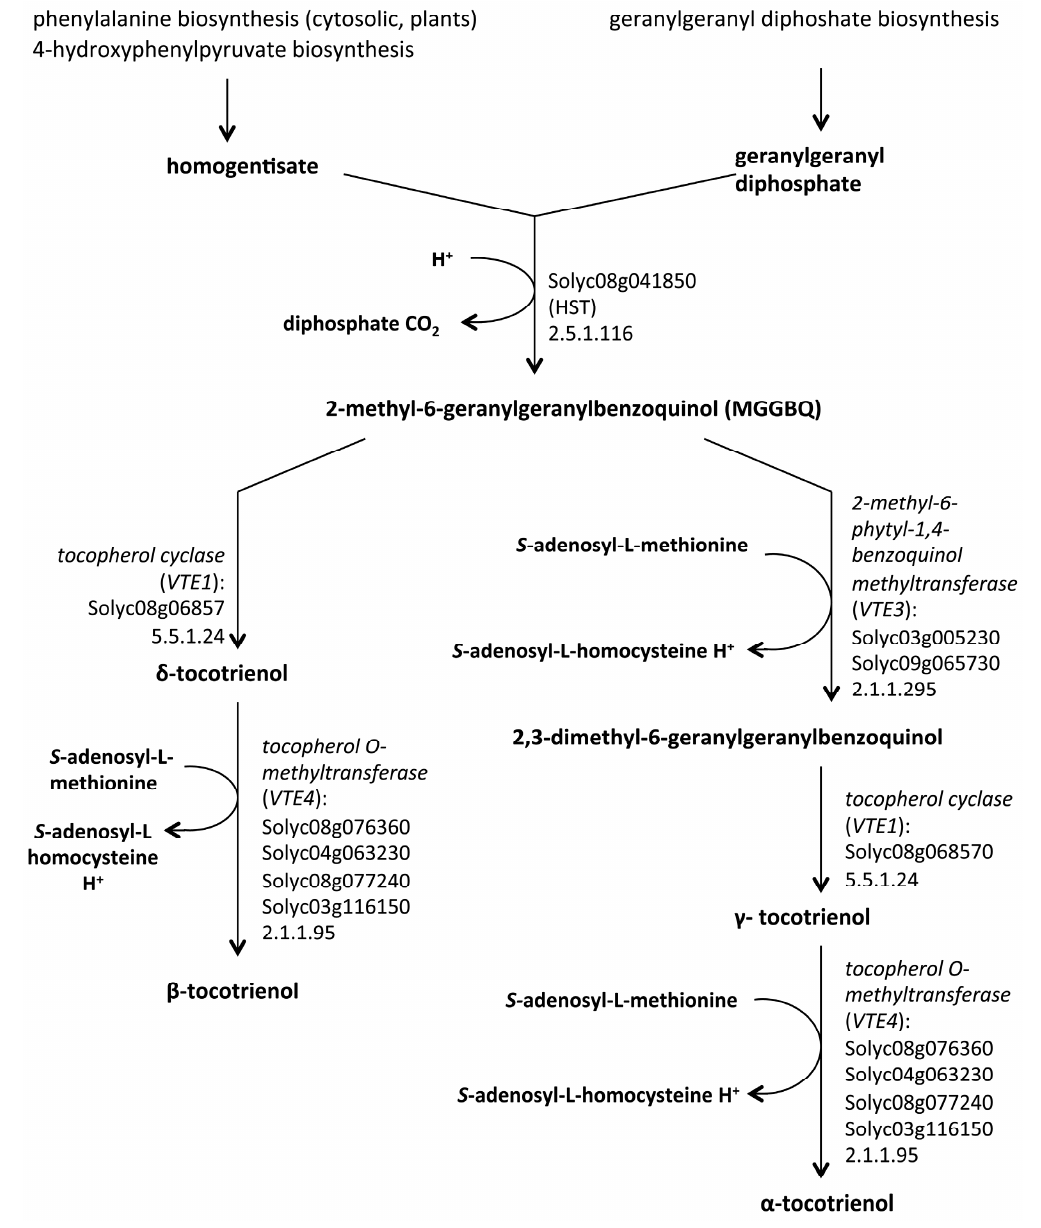
Figure 2. The tocotrienol biosynthetic pathway in Solanum lycopersicum as described in MetaCyc [61].